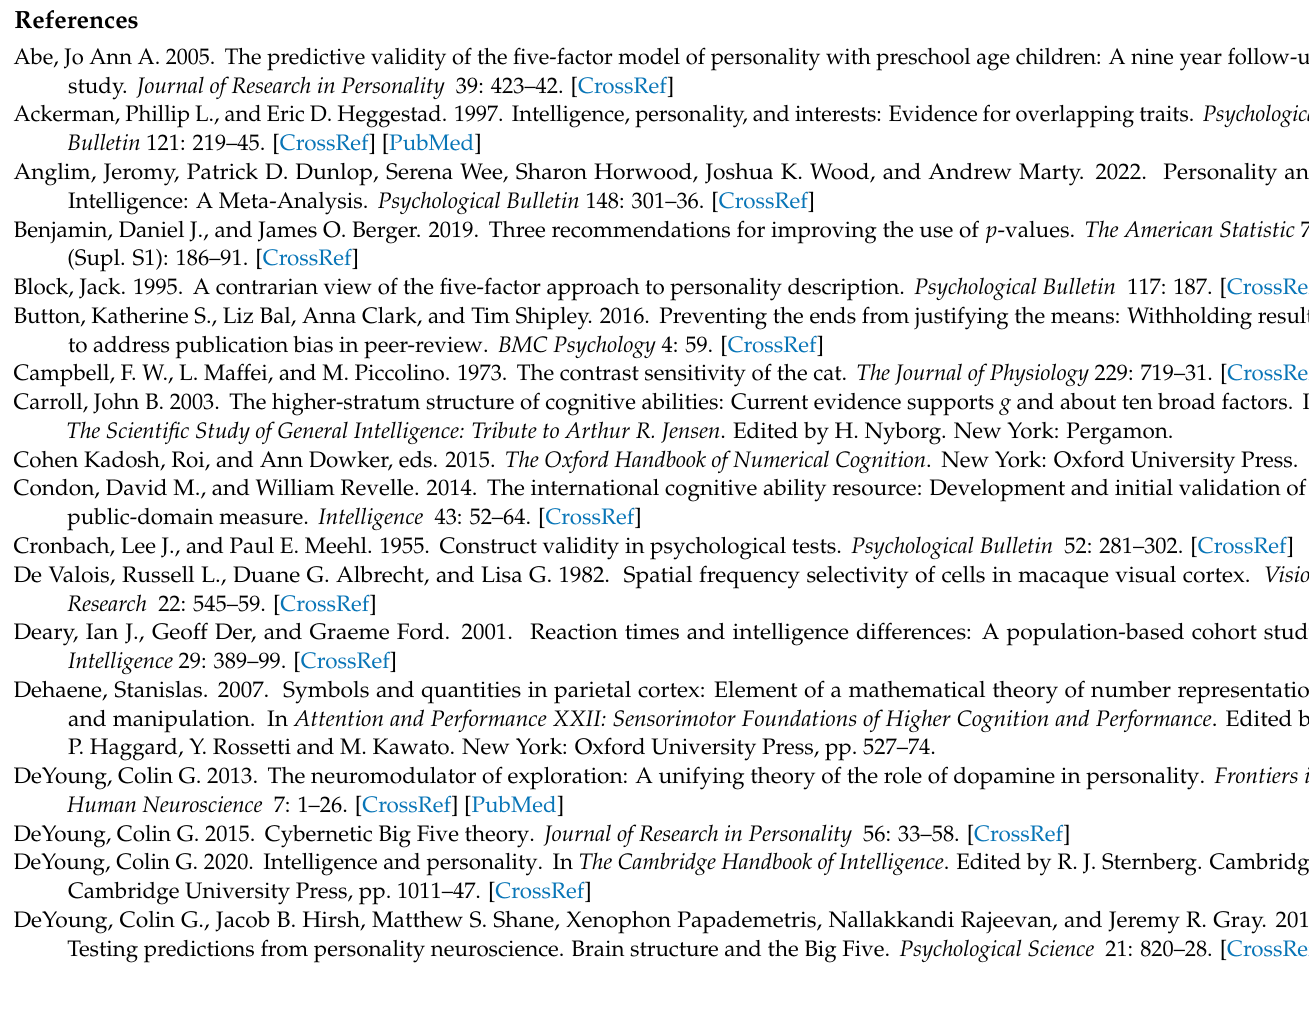
To account for multiple comparisons, p -values indicated from correlations in Table 5 were adjusted using a Bonferroni correction. These results are shown in Appendix Table